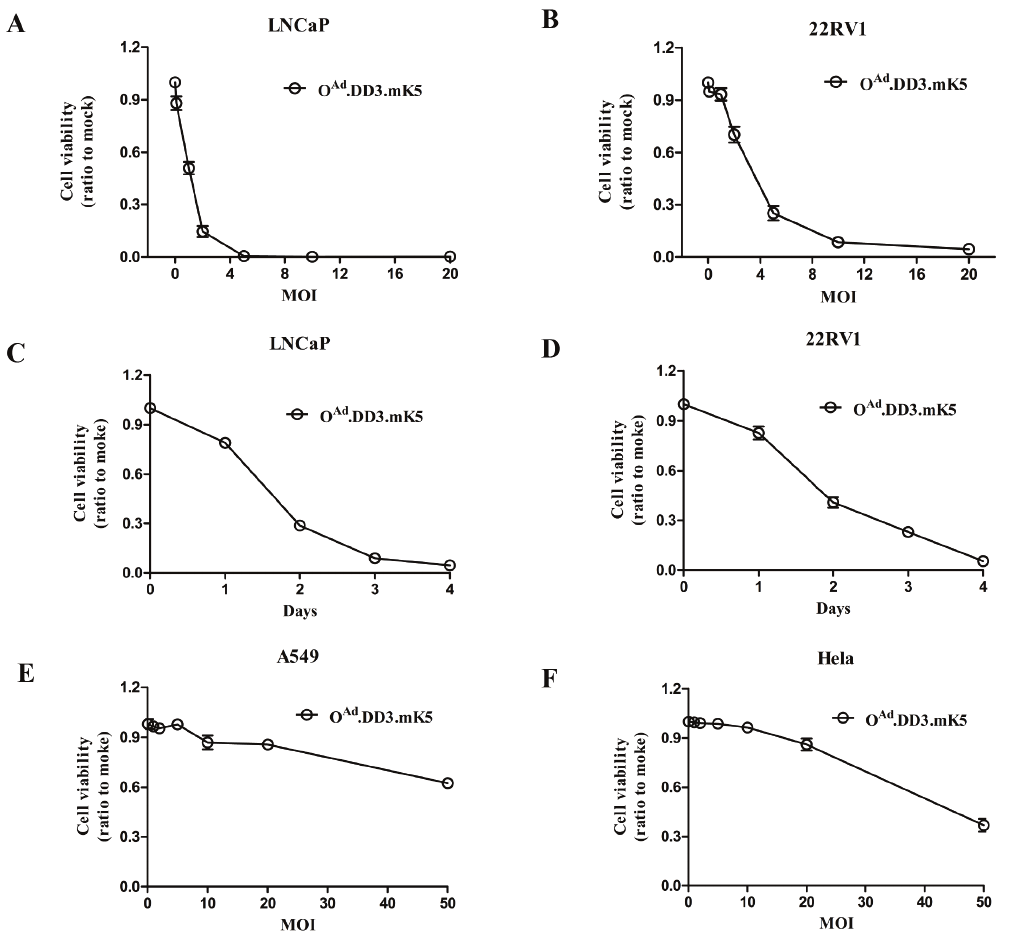
Figure 3: O Ad .DD3.mK5 displays antitumor activity in vitro. A-B. Cell viability of LNCaP and 22RV1 cells infected with O Ad .DD3.mK5 at a series of MOIs on day 4. C-D. Cell viability of LNCaP and 22RV1 cells infected with O Ad .DD3.mK5 for 4 days at 10MOI. E-F. Cell viability of A549 and Hela cells infected with O Ad .DD3.mK5 at various MOIs on day 4. All date were repeated three times. The bars represent the mean ± S.D. (n =